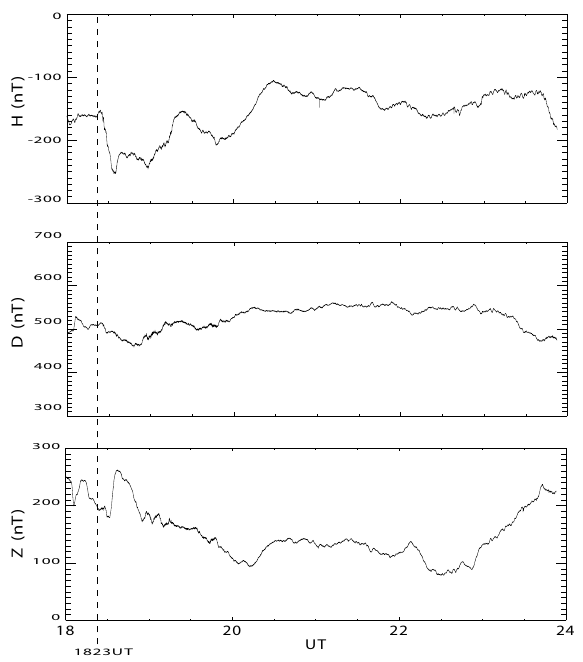
Fig. 4. 210 MM magnetometer data from the Tixie station in H , D and Z -components, from 18:00 to 24:00 UT. Substorm onset at 18:23 UT indicated by a vertical dashed line.